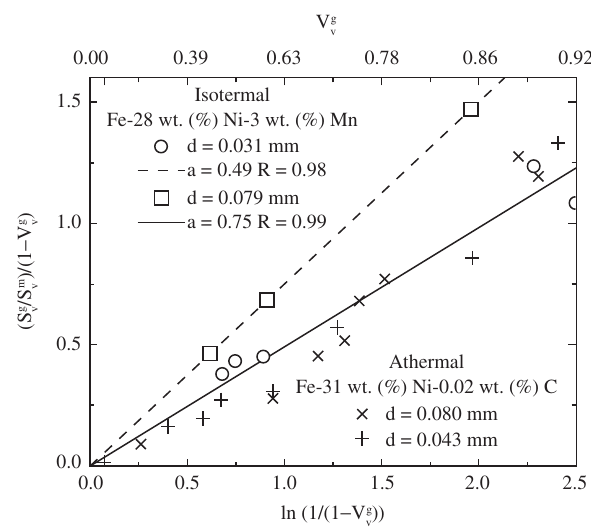
Table 2. Fe-28 wt. (%) Ni-3 wt. (%) Mn for Ghosh 10,11 - isothermally transformed at 153 K - γ , γ , Ι and t obtained from the analysis of s v 0,lower experimental data. Figure 2. Microstructural path of isothermal martensite spread. The theoretical result, Equation 6, is compared with experimental data from a Fe-23.4 wt. (%) Ni-2.8 wt. (%) Mn alloy obtained by Ghosh 10,11 . The correlation coefficient, R, is also shown. The fine-grained isothermal martensite and the athermal martensite follow the same microstructural